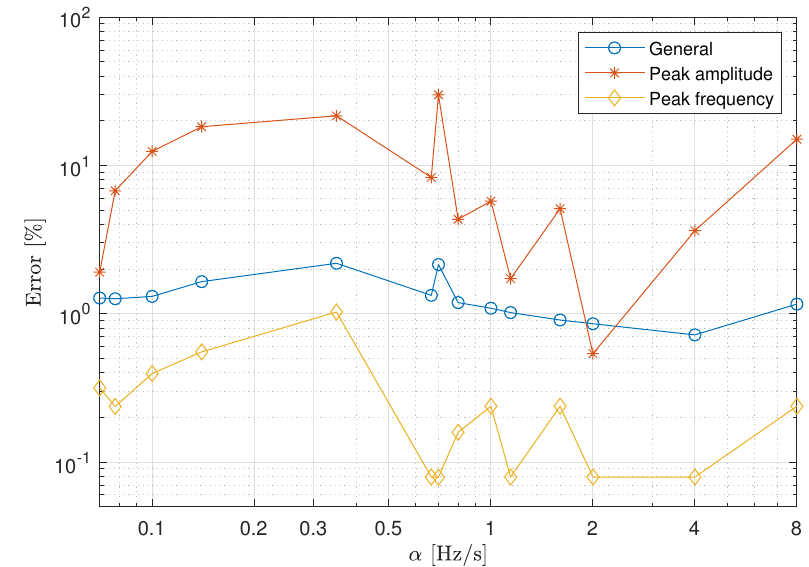
Figure 10. Estimated errors in the experimental transmissibility for the spring coil